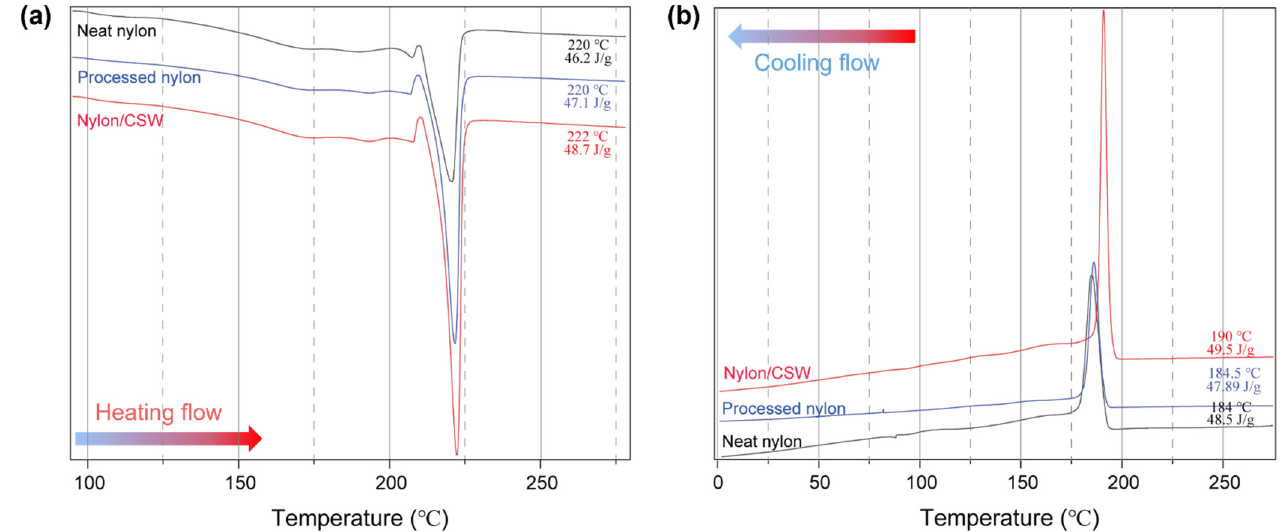
Figure 3. DSC thermograms of neat nylon, processed nylon, and nylon/CSW nanocomposite (sample stirred for 1.5 h). ( a ) Second melting temperature: T m, and ( b ) first cooling crystallization temperature: T c .